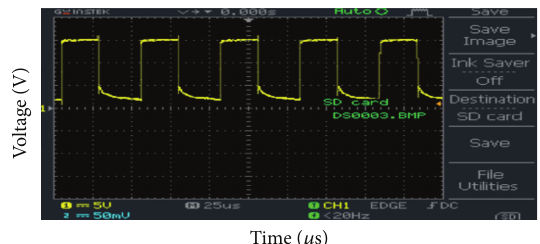
Figure 9: Hardware experimental setup.